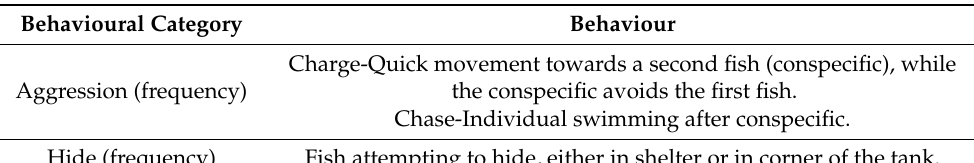
Table 1. List of behaviours displayed by two-spotted goby, Pomatochistus flavescens during the routine behaviour